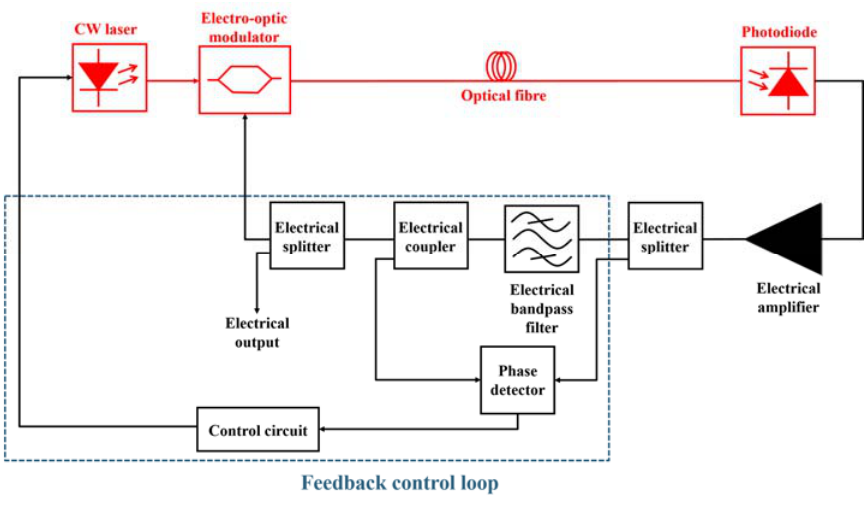
Figure 6. OEO with a feedback-control loop